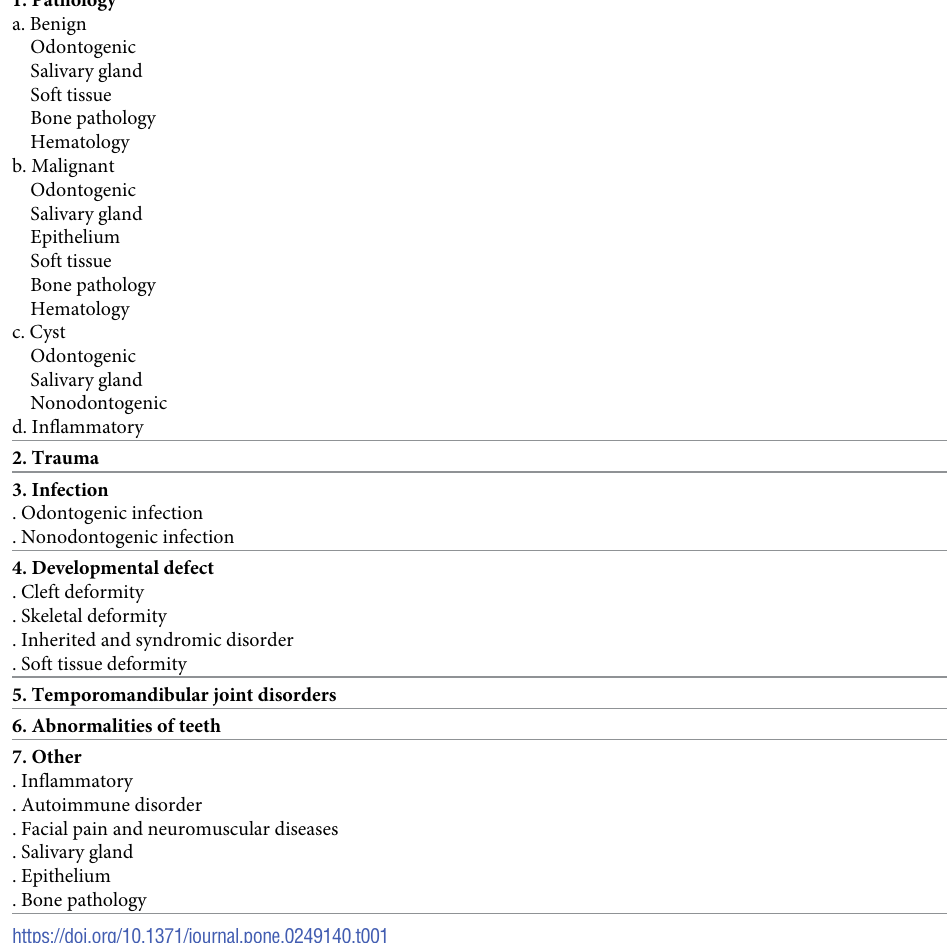
Table 1. The diagnosis groups, classification and subclassification of the study.